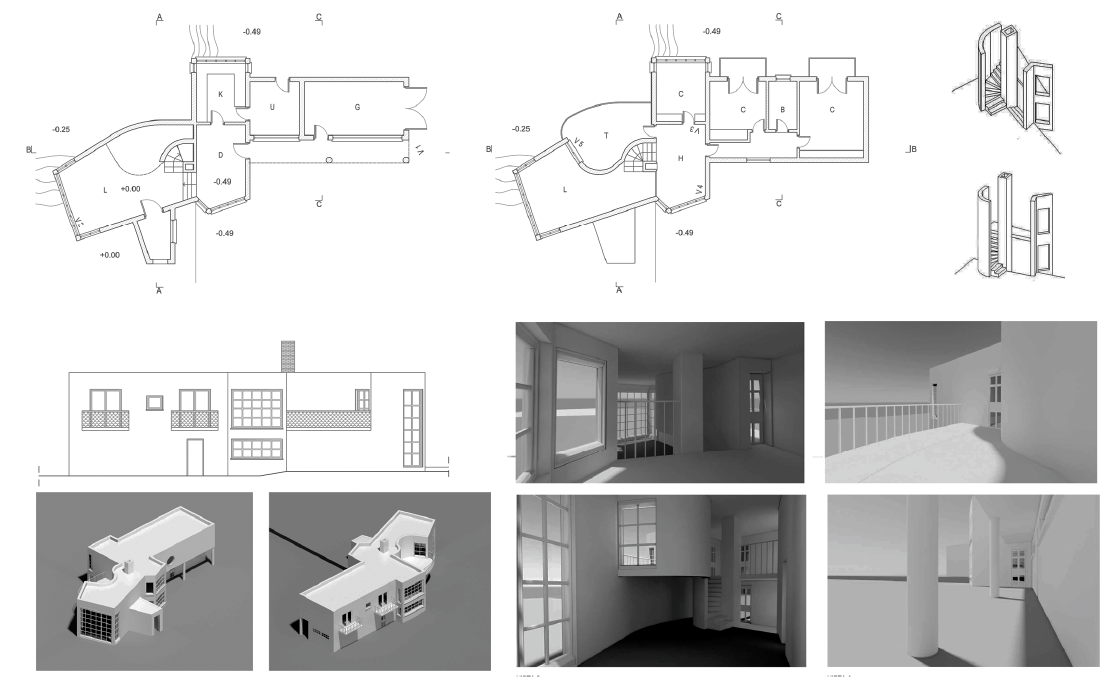
Figure 5. House 5. Plans, front, schemes, isometric views, perspectives (C.